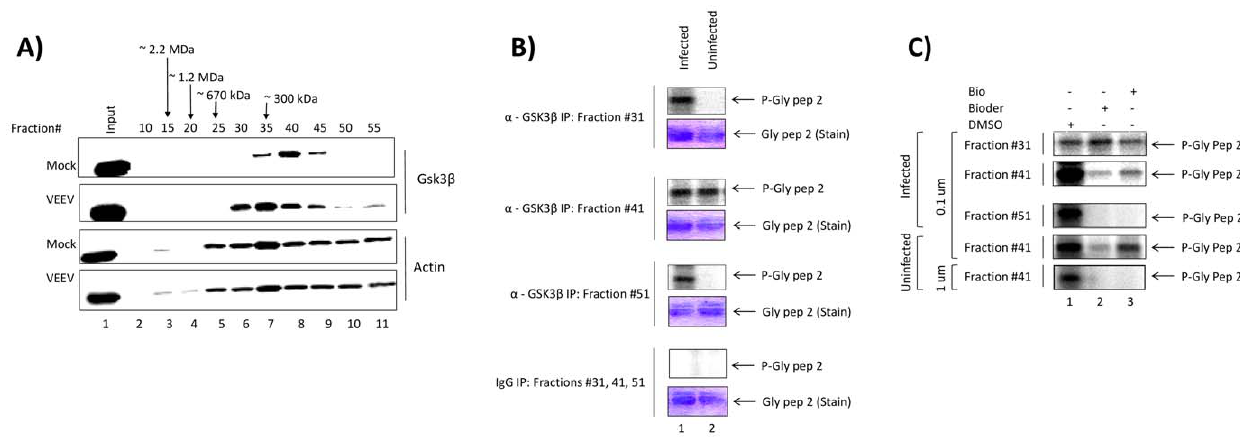
Figure 5. Presence of novel GSK-3 b complexes in VEEV infected cells. A ) Samples from both infected and uninfected cells were loaded on a sizing column and separated in presence of a 500 mM salt buffer. No detergents were used during the chromatography steps. Each fraction (over a range of 60 fractions) contained 500 m L and only 250 m L samples were precipitated, resuspend in low volume of TNE 50 and 0.1% NP-40 (10 m L) and ran on a gel for western blotting. Samples were western blotted for presence of GSK-3 b and actin. B ) GSK-3 b IPs from fractions 31, 41, 51 (100 m L each) were mixed with GSK-3 b Ab (5 m g) overnight and washed next day first with RIPA buffer (1 6 ) and then TNE 50 and 0.1% NP-40 (2 6 ) followed by kinase buffer (3 6 ) prior to addition of substrate and 32 P-ATP. Samples were ran on a gel, stained, destained (over 4 hrs), dried and then exposed to phosphoImager cassette. Control immunoprecipitation from these fraction (50 uL each) were mixed and used for IP/Kinase using IgG (5 m g). C ) IP/ kinase reactions were treated with either BIO or BIOder (0.1 uM or 1 m M) in vitro during the kinase reaction. Samples were ran on a gel and exposed to phosphoImager cassette.